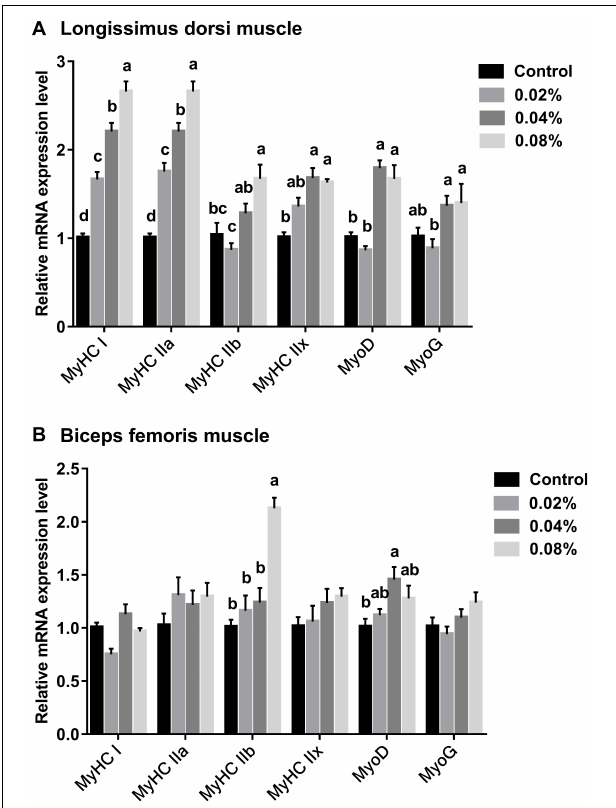
FIGURE 3 | Effects of different levels of dietary CGA supplementation on relative mRNA expression levels of different muscle fiber and myogenic regulatory factors in LD (A) and BF (B) muscles of finishing pigs. Values are means, with their standard errors represented by vertical bars. Values with different letters (a–d) differ ( P <